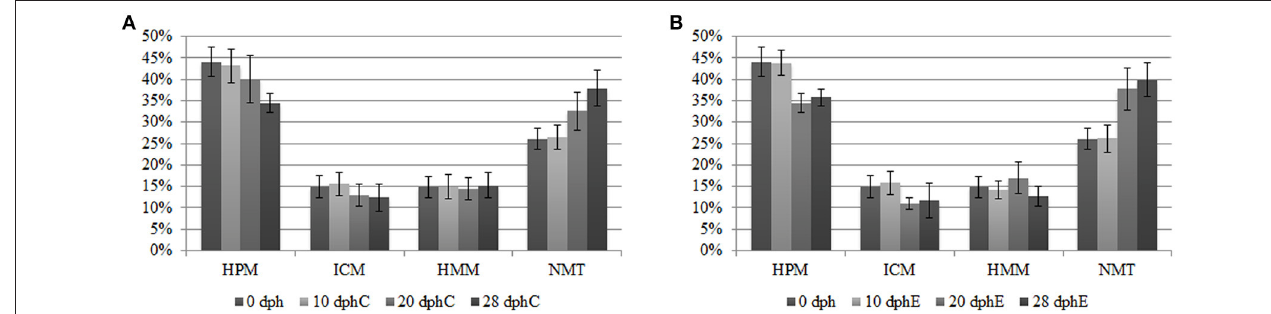
FIGURE 1 | DNA methylation status of methylation-sensitive loci from MSAP ( HpaII / MspI comparison) in O. vulgaris paralarvae (expressed as percentages) measured at 0, 10, 20, and 28dph. Methylated loci corresponded to categories: ICM, internal cytosine methylated; HMM, hemimethylated; HPM, hypermethylated, and no methylated loci is referred as NMT, non-methylated. Percentages are referred to the total number of polymorphic loci after the error rate filtering. (A) Control diet MSAP status. (B) Enriched diet MSAP status.